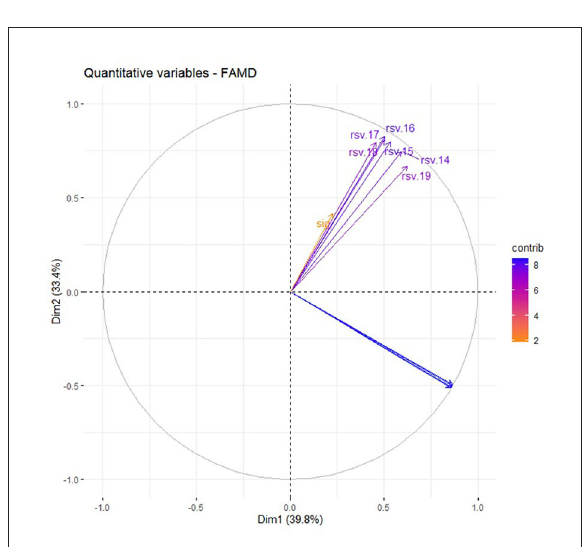
FIGURE4 Relationship between variables and their contribution to dimensions 1 and 2.